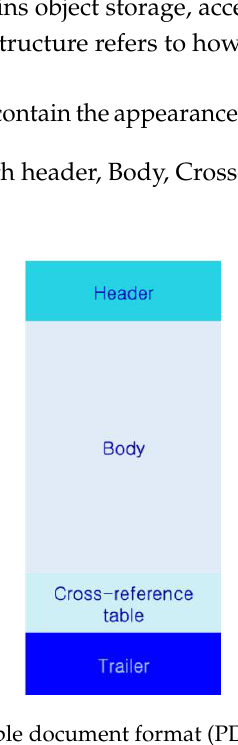
Figure 1. Portable document format (PDF) file structure.